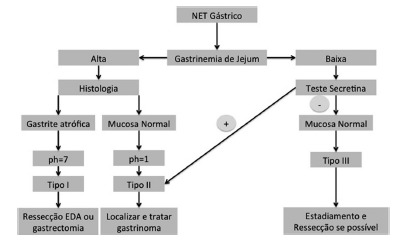
Treatment algorithm